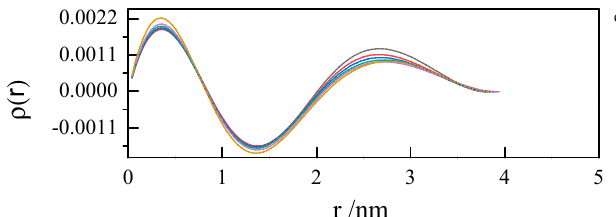
Figure 13. Pair distance distribution functions derived from SAXS data by indirect Fourier transform for 8-6-8 surfactant system at concentrations ( a ) 0.098 mol dm − 3 , ( b ) 0.112 mol dm − 3 , ( c ) 0.149 mol dm − 3 , ( d ) 0.185 mol dm − 3 , ( e ) 0.222 mol dm − 3 at 293.15 K, 298.15 K, 303.15 K, 308.15 K, 313.15 K, 318.15 K. Int. J. Mol. Sci. 2020 , 21 , x FOR PEER REVIEW